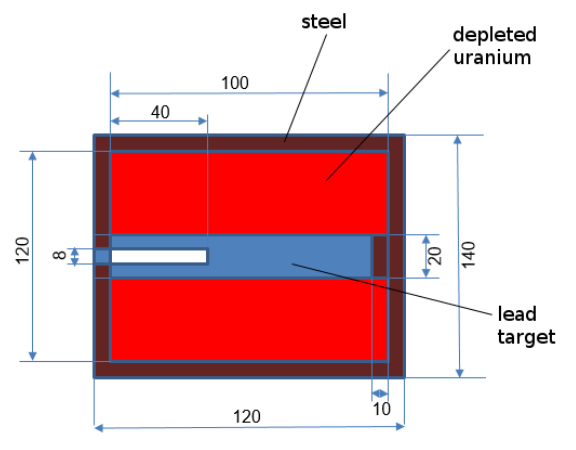
Figure 3. B-URAN sectional view, lead target [8]